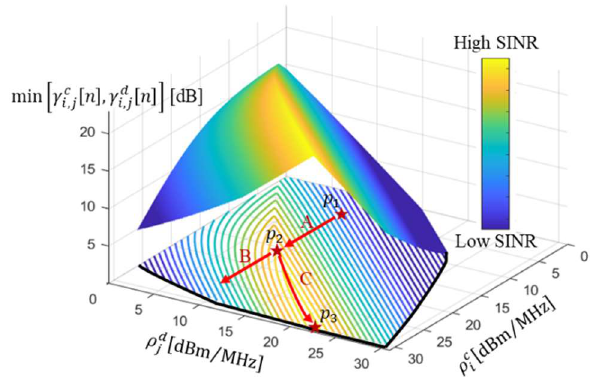
Figure 2. Geometrical interpretation of optimal power densities. Table 1. Observation at three representative points in the feasible